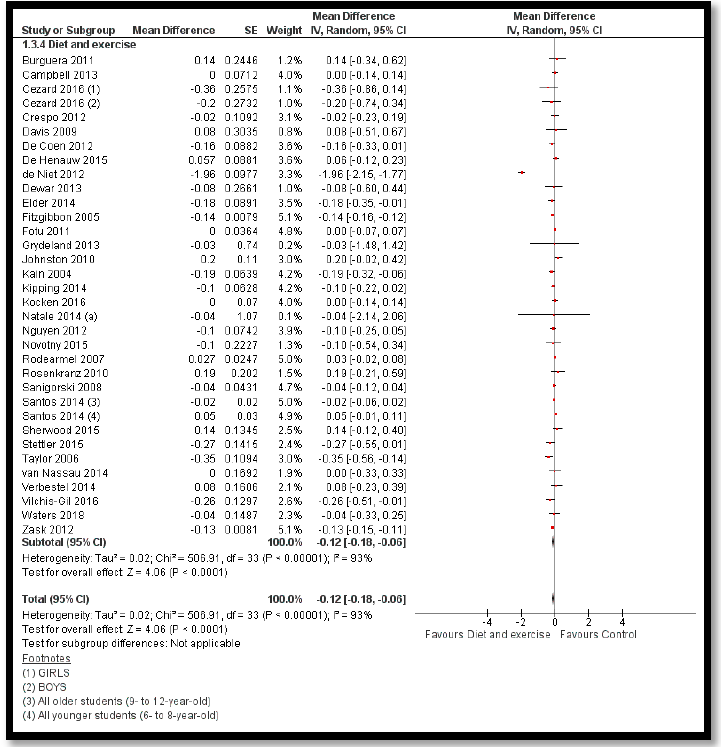
Figure 4. Forest plot for the effect of combined diet and exercise interventions for obesity prevention on body mass index (BMI) z -score .